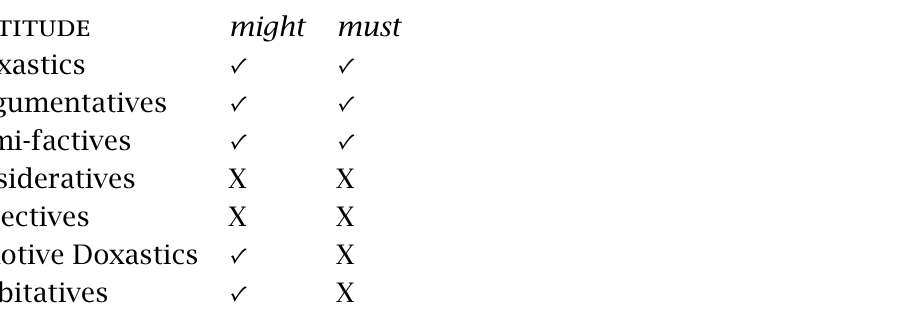
Compact representation of acceptability judgments, by attitude and modal